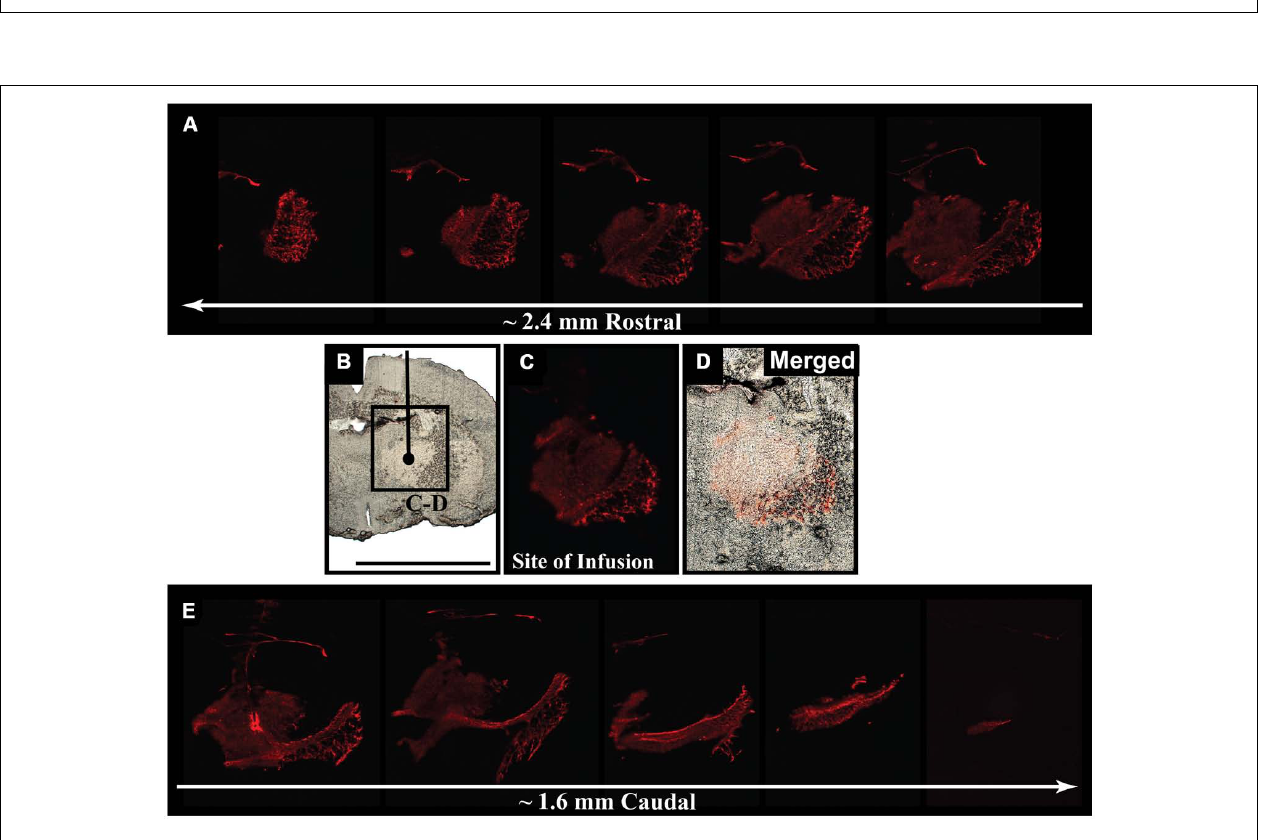
FIGURE 2 | Early parenchymal distribution of fluorescently labeled liposomes. (A–E) Acute survival time-point for liposome-infused animals revealed the rapid spread of fluorescently labeled liposomes 30 min after delivery into the thalamus. Spread of